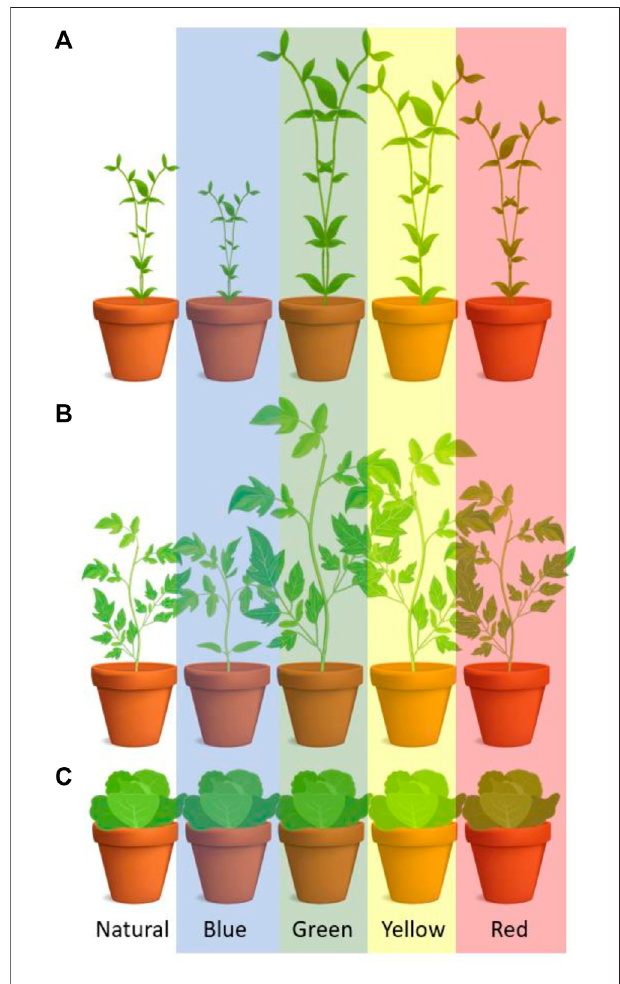
FIGURE 9 | Effect of light wavelengths on chrysanthemum (A) , tomato (B) and lettuce (C) . The light absorption maxima of the intact leaves are in the bands of 400 – 490 nm and 660 – 680 nm, which is close to maximum absorption bands of a chlorophyll extract (420 – 460 nm and 640 – 660 nm) (Mortensen and Strømme,